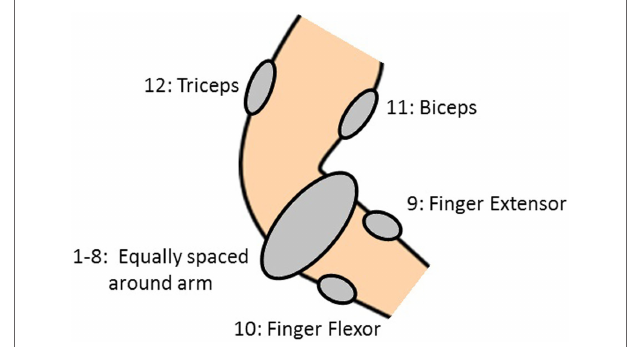
FIGURE 1 | Location of the 12 sEMG electrodes on the arm.